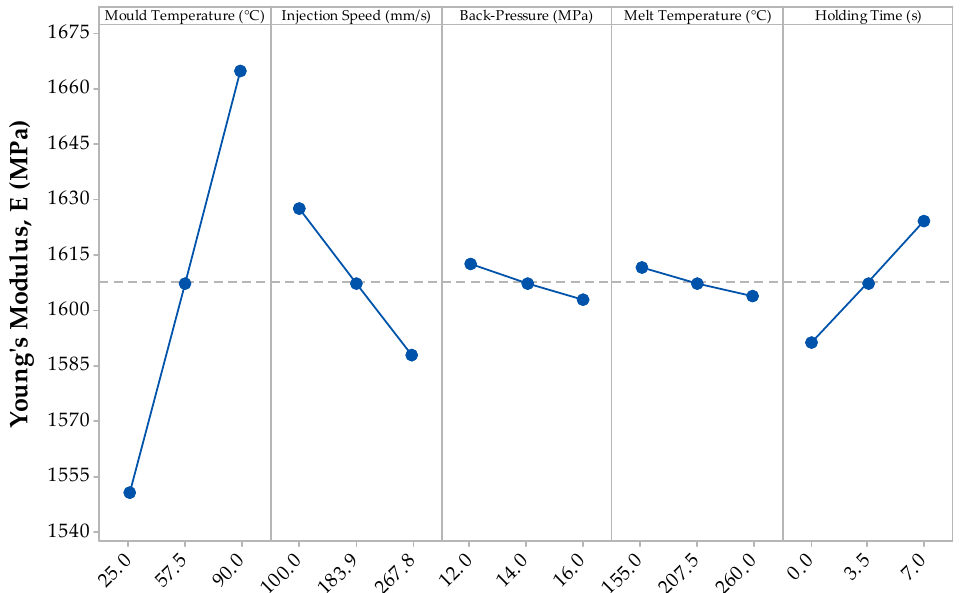
ff ects plot for the mean Young’s modulus (E) results from the Figure 3. Main effects plot for the mean Young’s modulus (E) results from the DoE. Figure 3. Main e